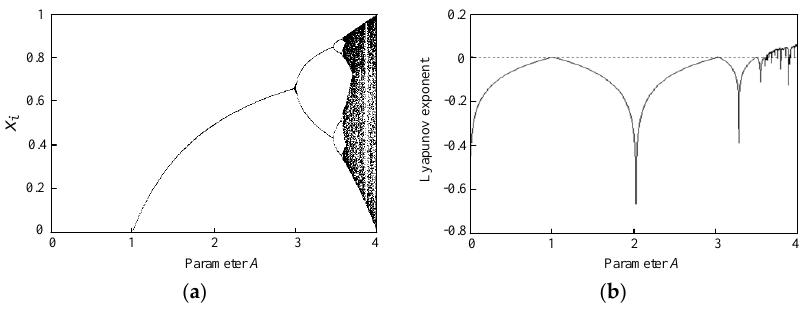
Figure 8. Logistic map: ( a ) bifurcation diagram; ( b ) Lyapunov exponents.